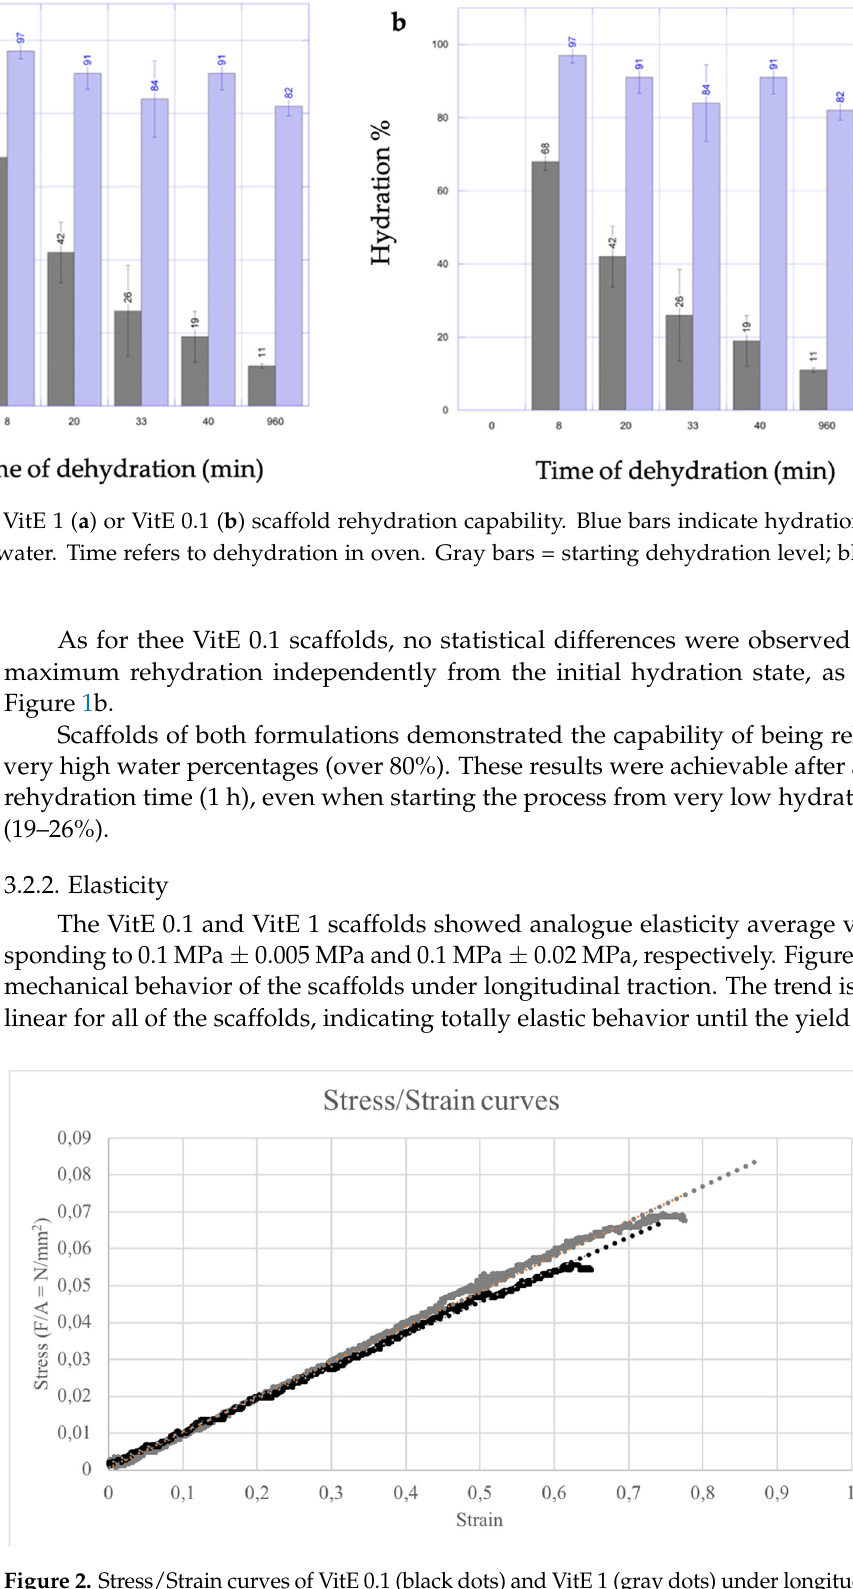
Figure 2. Stress/Strain curves of VitE 0.1 (black dots) and VitE 1 (gray dots) under longitudinal trac-